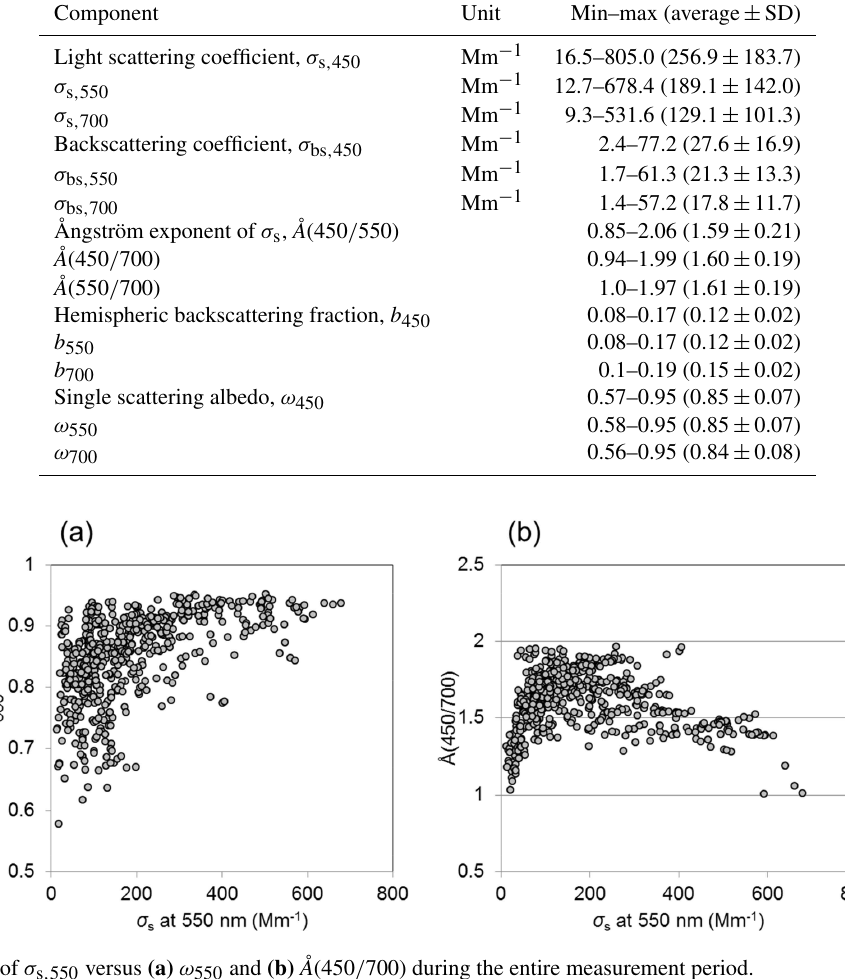
Figure 4. Scatter plot of σ s , 550 versus (a) ω 550 and (b) Å (450 / 700) during the entire measurement